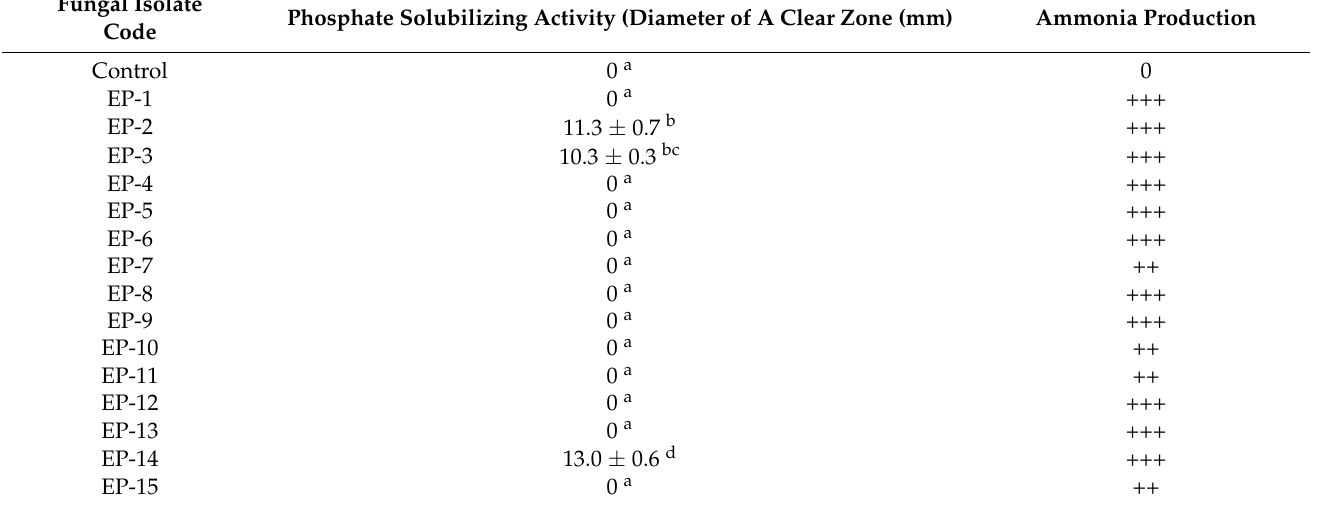
Table 4. Phosphate solubilizing activities and ammonia production of endophytic fungal strains isolated from Ephedra